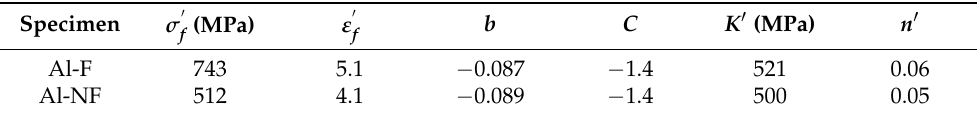
Table 3. ε -N curve parameters used in the FEM